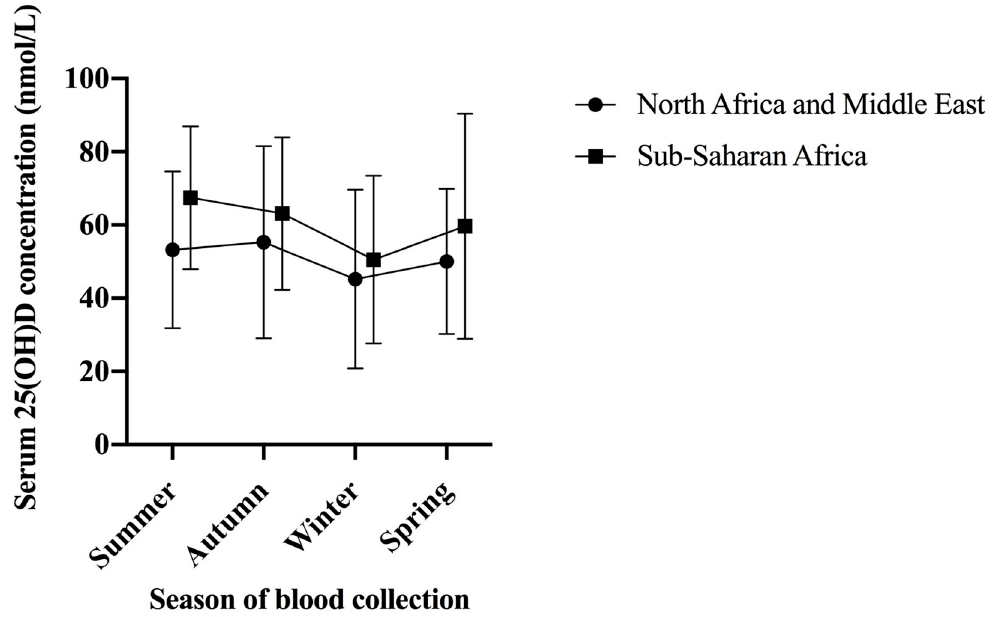
Figure 1. Mean (error bars ± 1 standard deviation) serum 25-hydroxyvitamin D concentration by season of blood collection in adults aged ≥ 18 years who were born in Africa and were included in the current study (North Africa and Middle East, n = 95; Sub-Saharan Africa, n = 141) in summer